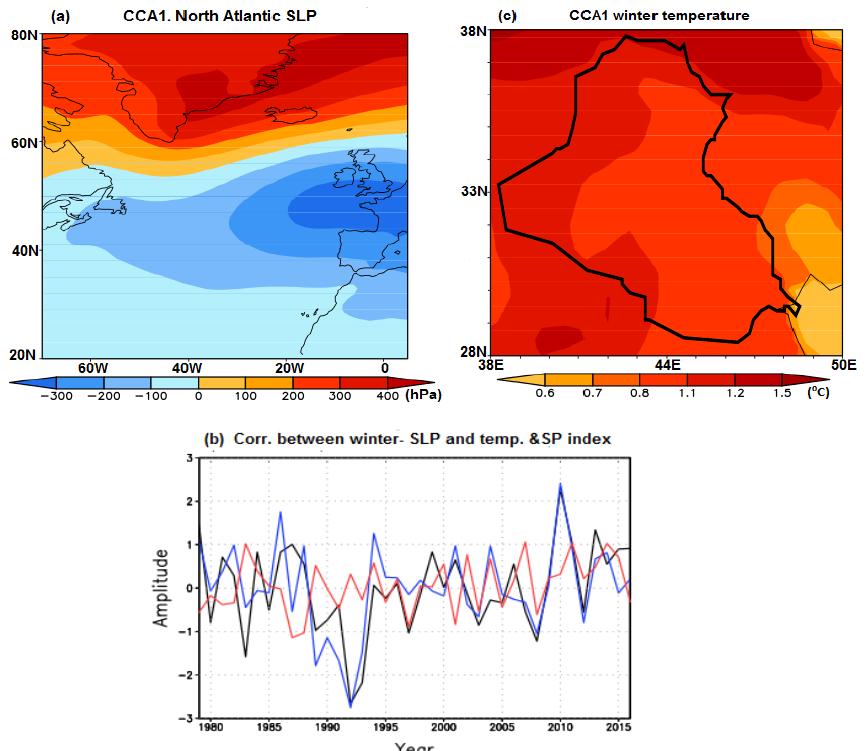
Figure 2. First pair derived through CCA between winter SLP of North Atlantic sector and Iraq winter temperature fields, extending over the 1979–2016 period. ( a ) SLP map, explaining 32.22% of the total variance; ( b ) SLP (blue line), Iraq temperature (black line) time series associated to patterns in panels ( a , c ), the correlation between these two time series is 0.76; ( c ) temperature map, explaining 54.73% of the total variance. The NAO index (red line in panel ( b )) is correlated with the SLP time series at the 0.35 level. The black contour line in panel (c) marks the Iraq border.